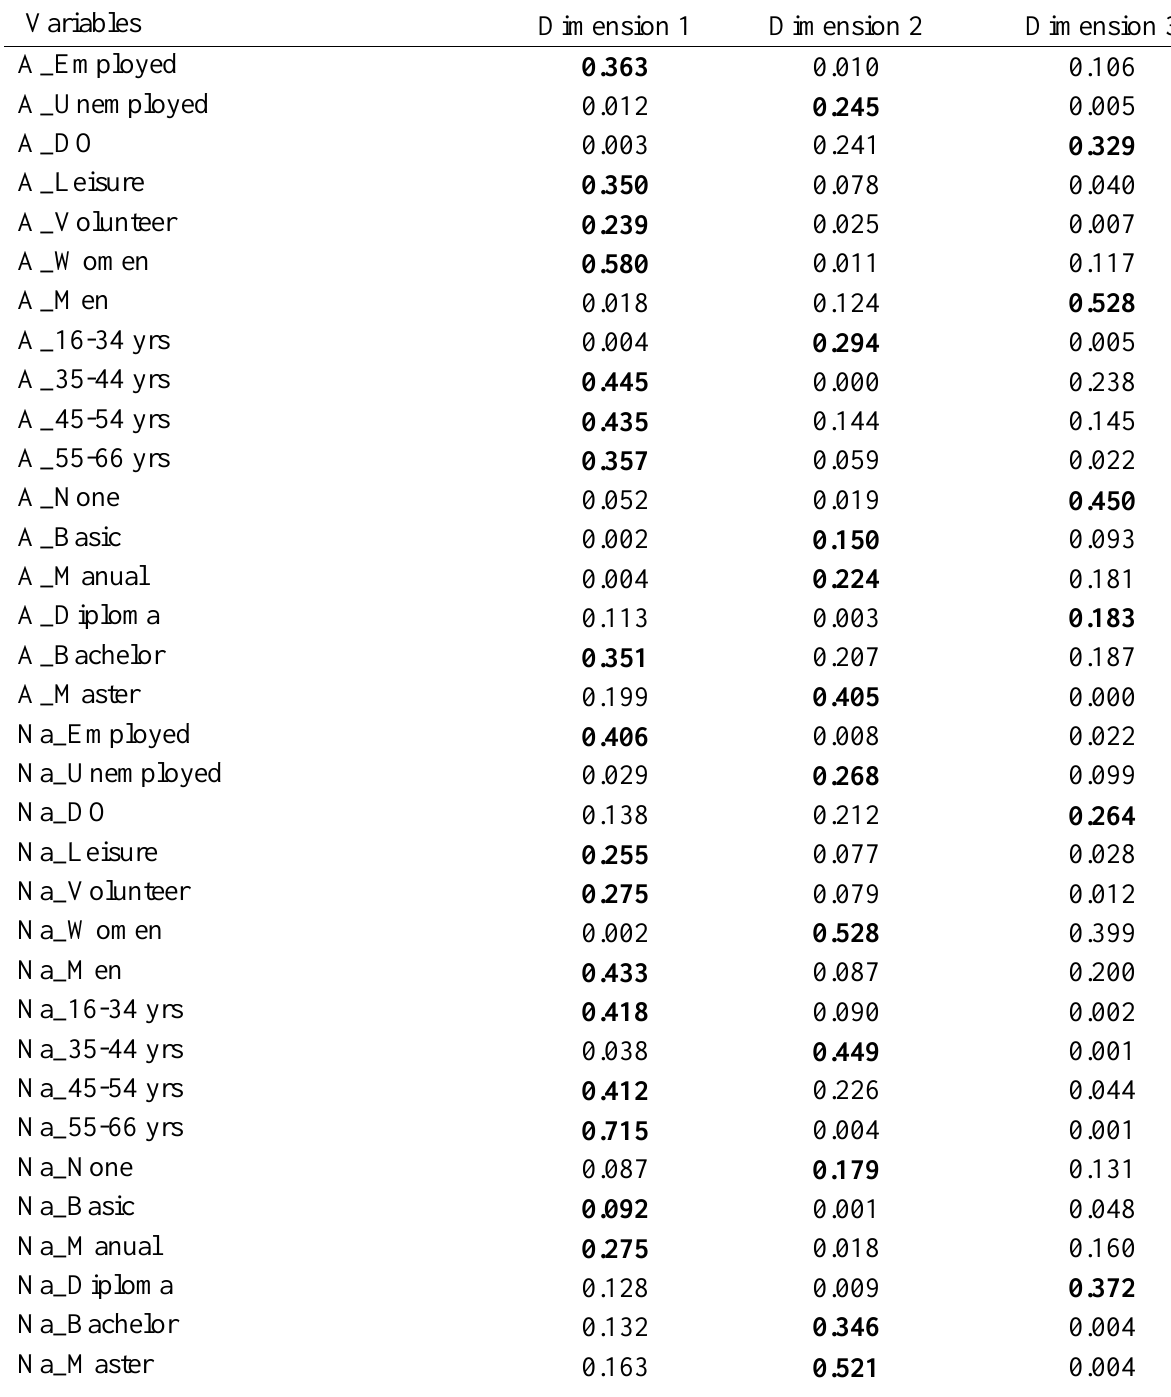
Table 2 - Squared Cosines of Categories of Activity to Dimensions in the Analysis Variables Dimension